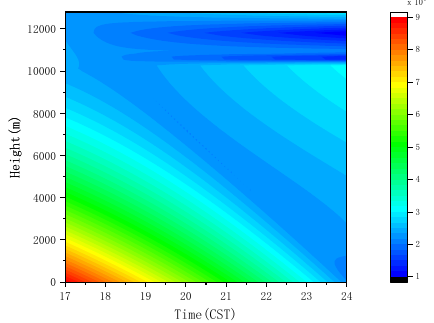
Figure 6. THI diagram of atmospheric aerosol distribution